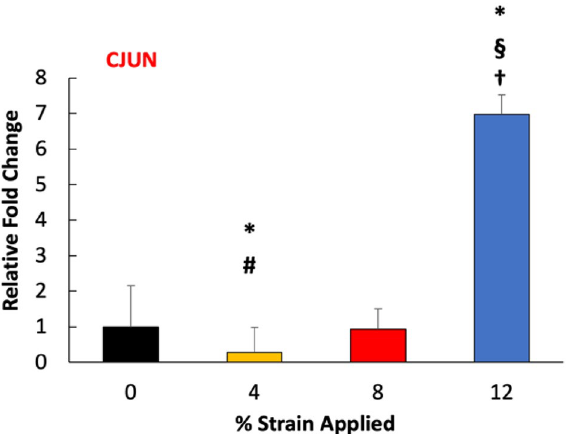
Figure 5. Effect of mechanical strain on the gene expression of early mechanoresponsive c-jun. *Indicate significant difference with respect to 0% strain group (control) with P < 0.05. # Represent significant difference between 4 and 8% mechanical strain groups, § represent a significant difference between 8 and 12% mechanical strain groups, and † represent a significant difference between 4 and 12% strain groups, each with a 0.05 P-value.